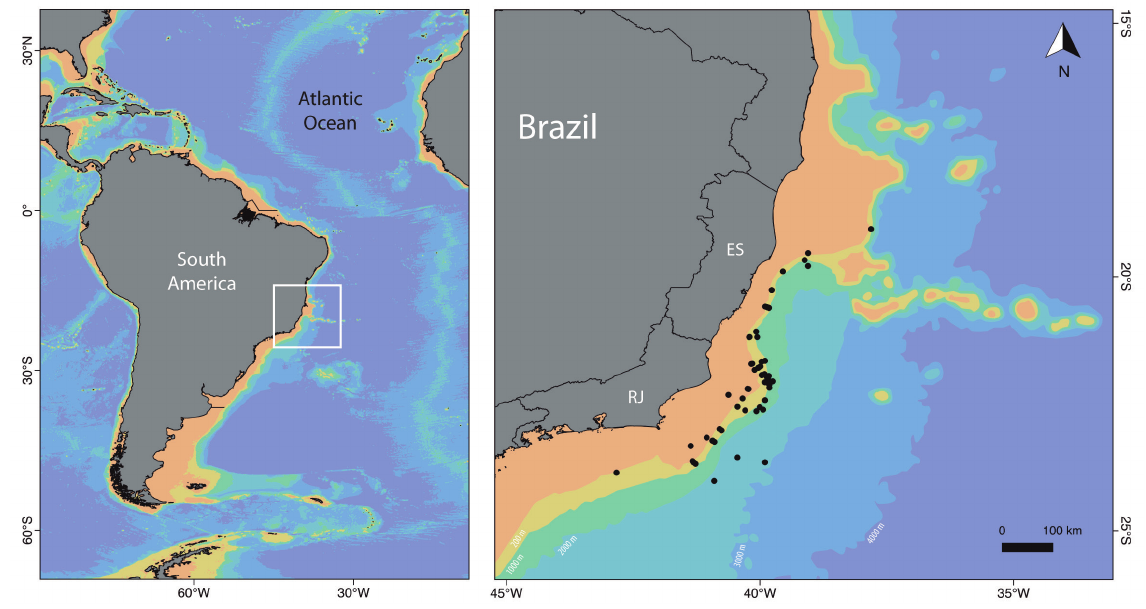
Fig. 1. Map showing sampling localities during scientific expeditions carried out along the Brazilian continental shelf and slope area from 1999 to 2016. Abbreviations: ES = Espírito Santo; RJ = Rio de